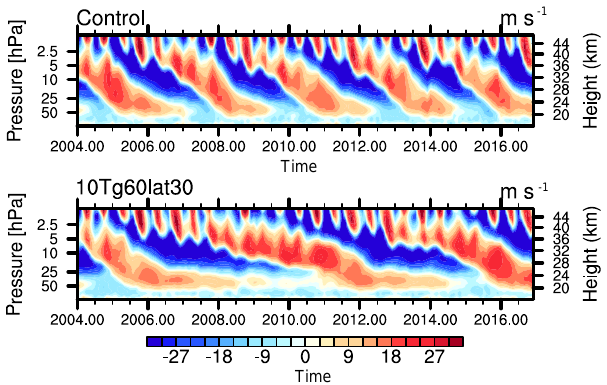
Figure 11. Zonal mean zonal wind velocity at the equator for the control simulation and for an injection of 10Tg ( S ) yr − 1 r between 30 ◦ N and 30 ◦